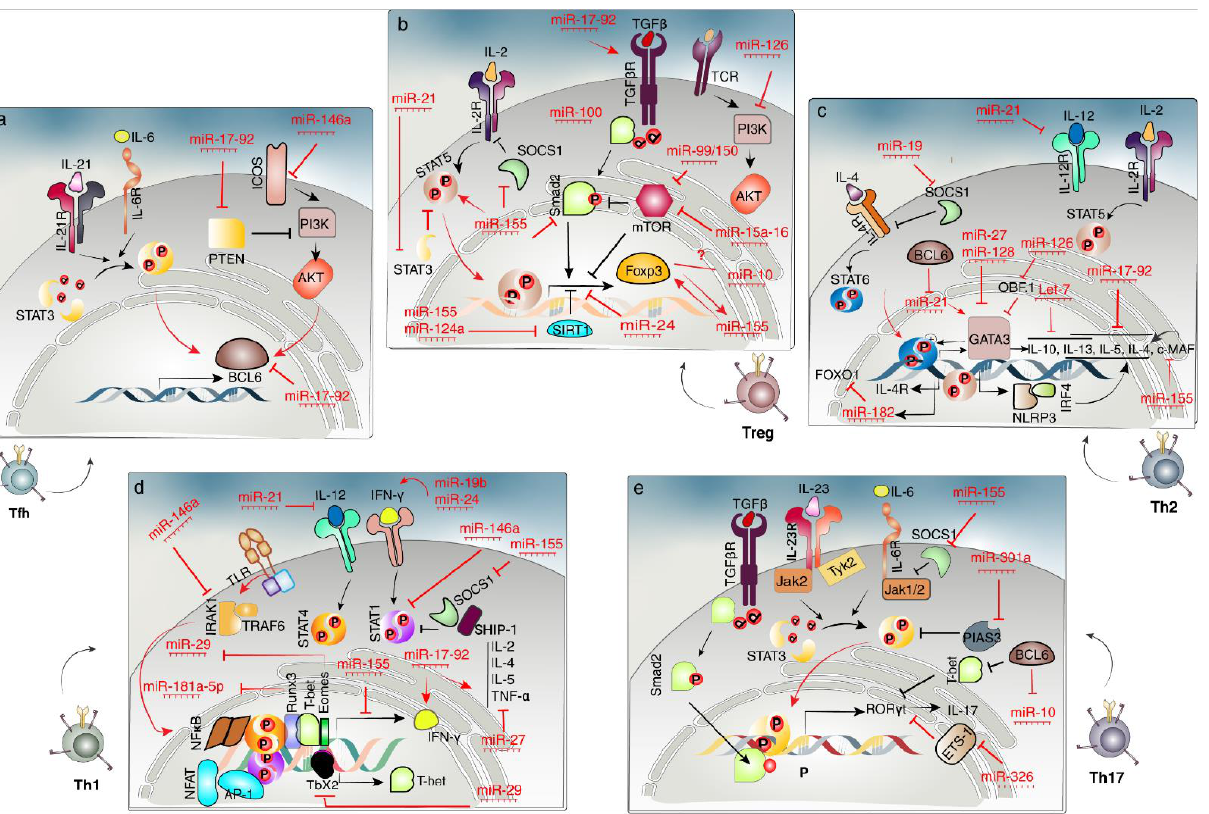
Figure 3. Schematic of the miRNAs ’ interaction with transcription factors, signaling pathways, and genes, which are prominent in Tfh ( a ), Treg ( b ), Th2 ( c ), Th1 ( d ), and Th17 ( e ) cell subsets ’ differentiation. Abbreviations: TLR: Toll-like receptor; Jak 1/2: Janus Kinase 1/2; TYK2: Tyrosine Kinase 2; ETS-1: ETS Proto-Oncogene 1, Transcription Factor.